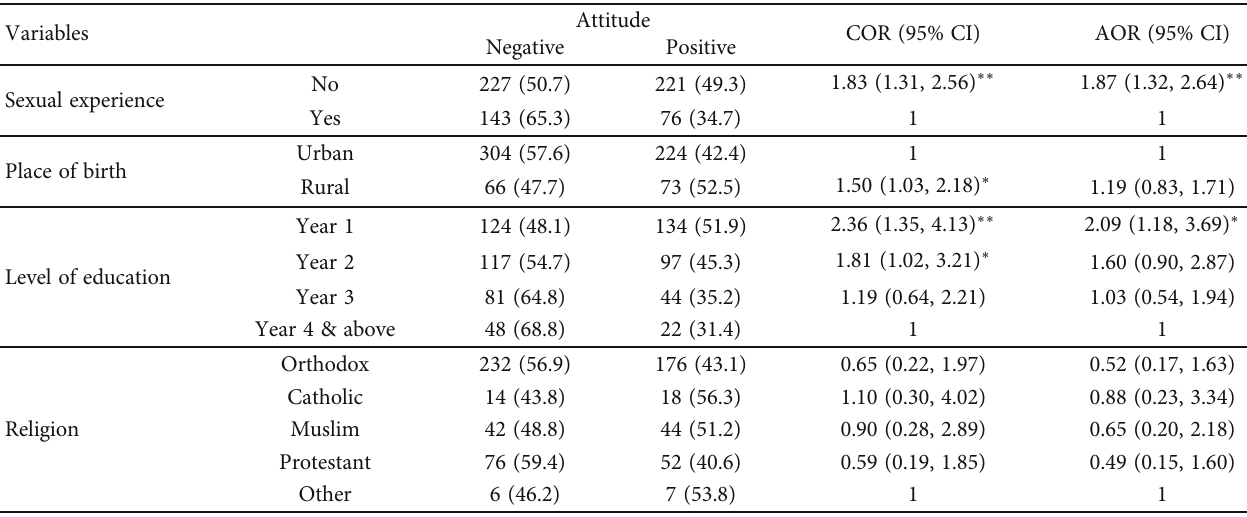
Table 7: Association of sociodemographic characteristics and attitude towards cervical cancer screening among respondents at Adama Science and Technology University, Adama, Ethiopia, May 2014. Variables